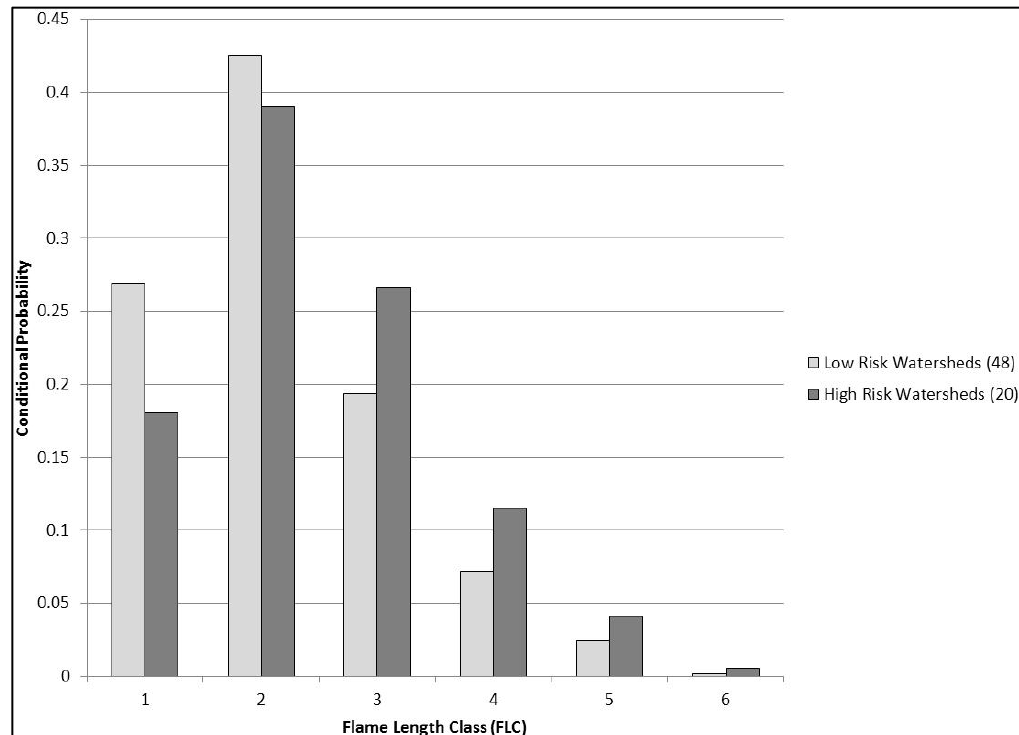
Figure 8. Comparison of conditional probabilities by flame length class (FLC), for the bottom 48 low risk watersheds (1st column in Figure 6) and the top 20 high risk watersheds (4th–10th column in Figure 6; Table